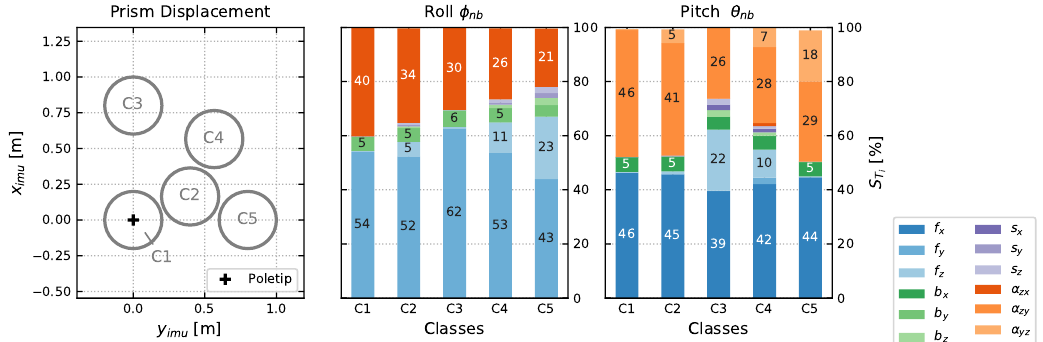
∗ 100 of IMU sensor model parameters on leveling for different pole tilts. Figure 5. Total effect terms S T i The classes are defined by regions of prism displacement up to 50gon tilt shown in the left